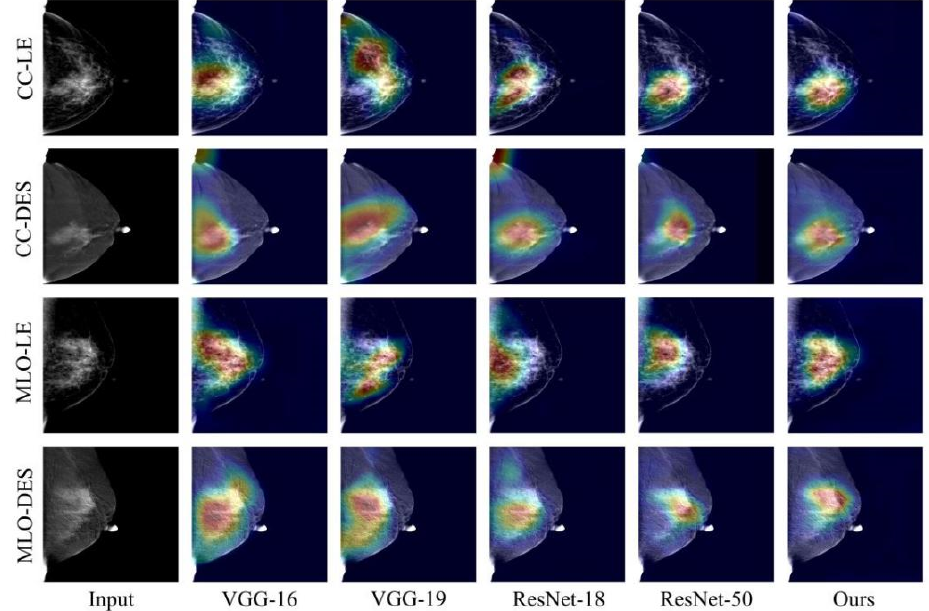
Figure 4. Visual interpretations generated by different methods using Grad-CAM. The first column shows the four input CESM images. The last column shows the visual interpretation generated by our method.